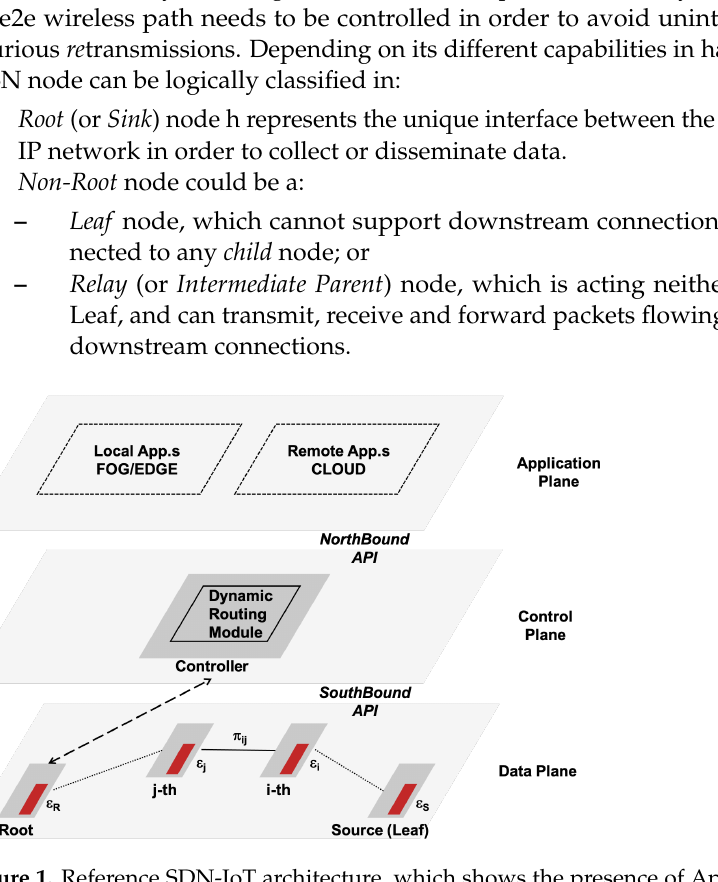
Figure 1. Reference SDN-IoT architecture, which shows the presence of Application, Control and Data Planes. AP is comprised of both local and remote applications, while CP is composed of a Controller with endowed the routing module (DRM). Finally, generic sensor nodes are within DP, where only Root is physically connected to the